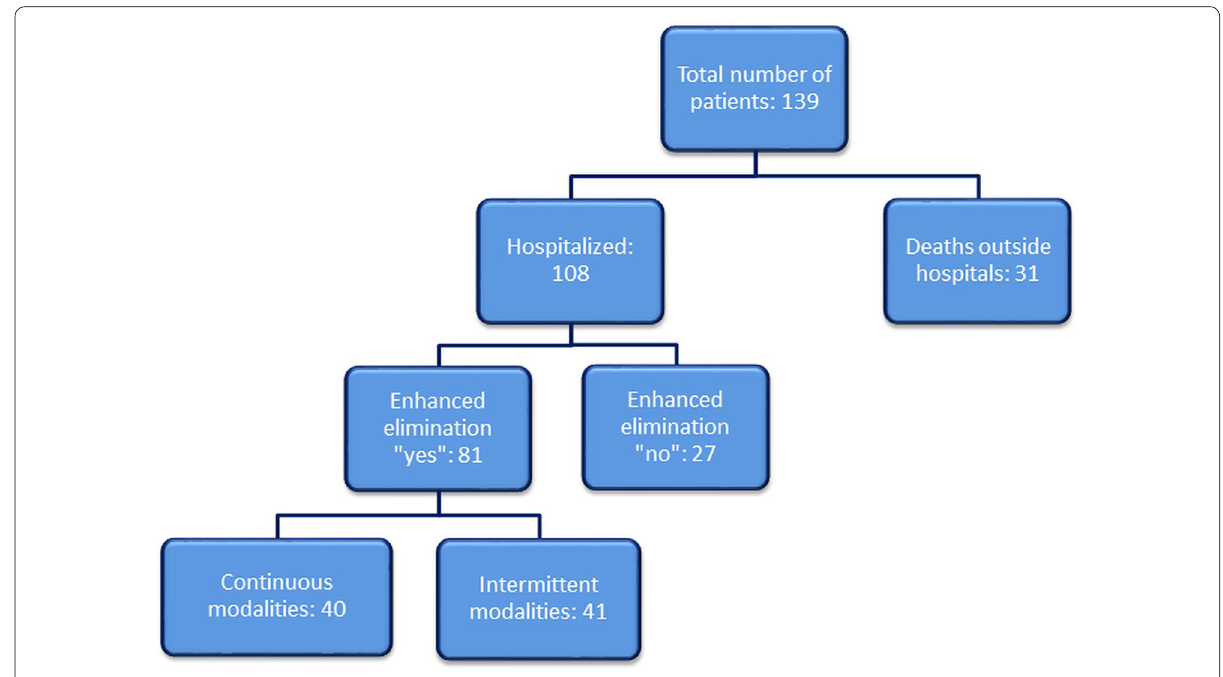
Fig. 1 Flowchart of the patients in the